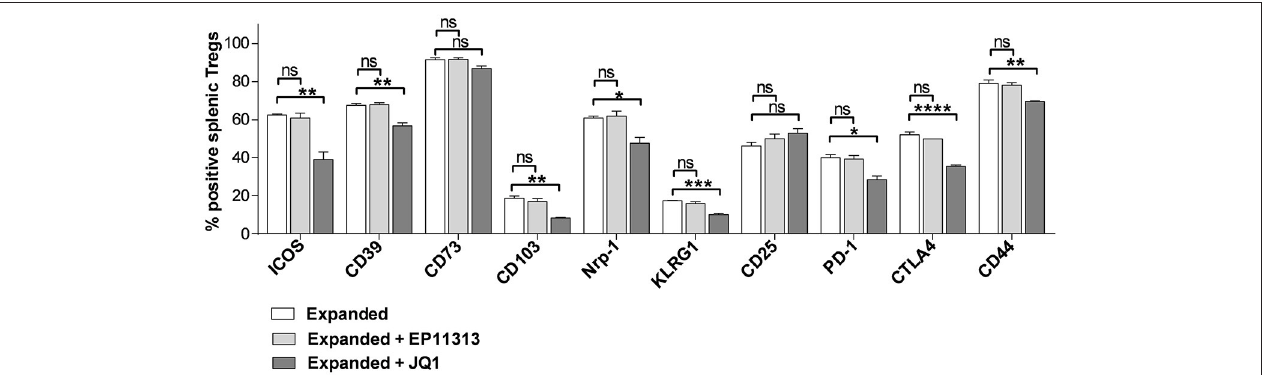
FIGURE 3 | In contrast to BETi EP11313, JQ1 modifies Treg phenotype. Mice were injected i.p. with TL1A-Ig and rmIL-2 bound to anti-IL-2 mAb as in Figure 1 and EP11313 (10 mg/kg), JQ1 (5–10 mg/kg) or vehicle on days − 1 to 6. Mice were sacrificed on day 7. Expression of activation, differentiation (i.e., ICOS, CD103, CD44, KLRG1) and functional (i.e., CD39, CD73, Nrp1, CTLA-4) molecules in splenic Tregs are shown. Data representative of five experiments (Treg expanded) and two independent experiments (expanded plus BETi) n = 3 mice/group. * p < 0.05; ** p < 0.01; *** p < 0.001; **** p < 0.0001 vs.